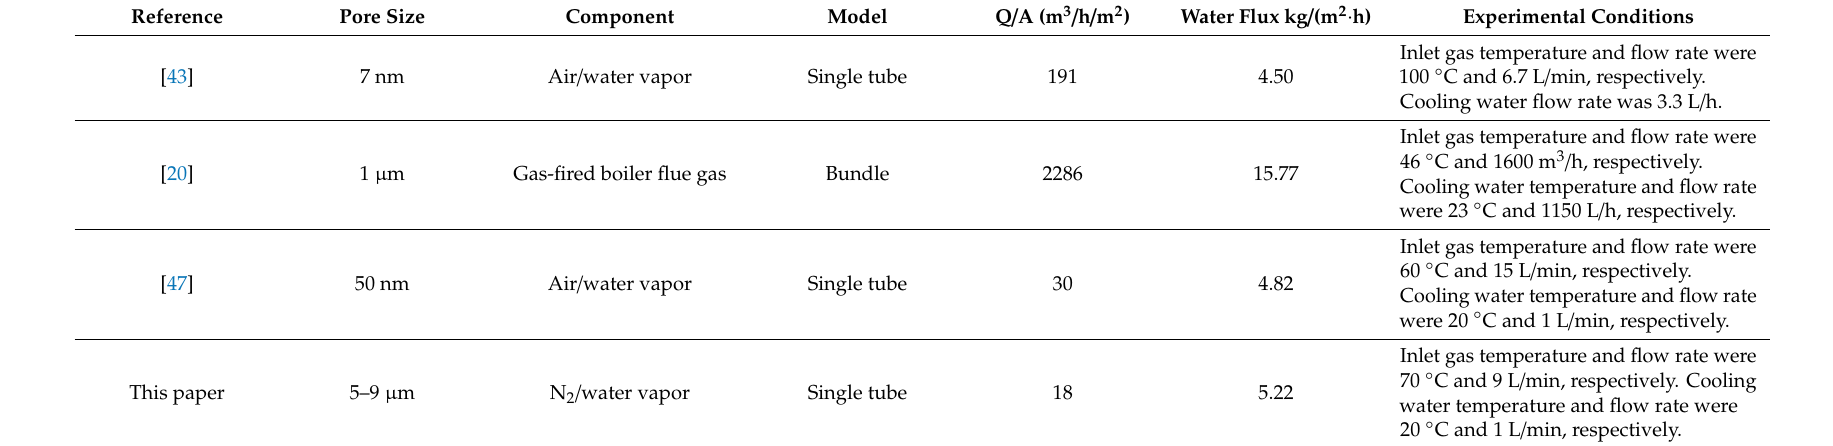
Table 4. Comparison of di ff erent researches (Q / A: the ratio of flue gas flow rate to membrane